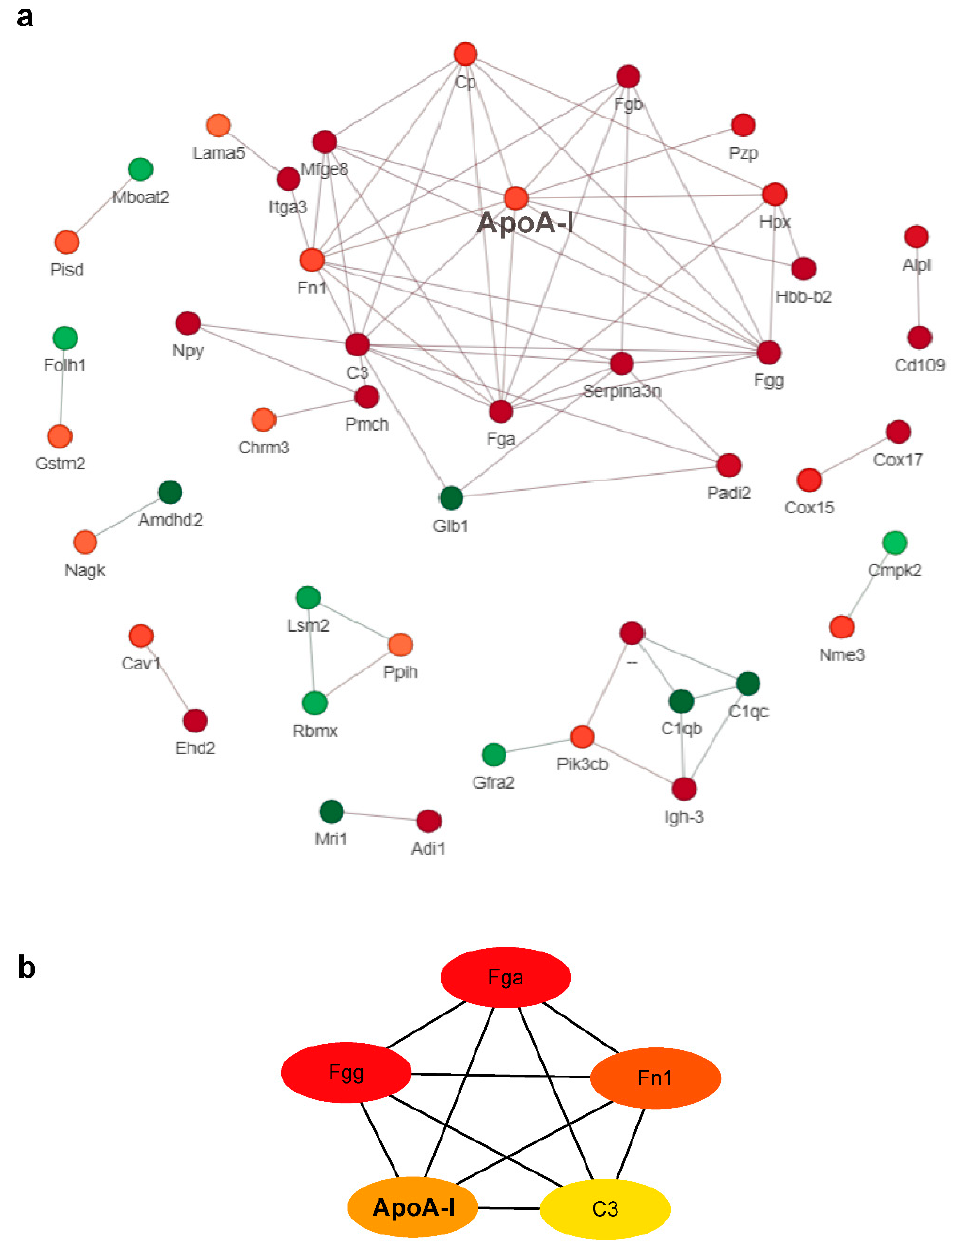
Figure 4. Protein–protein interaction network and screening of hub proteins. ( a ) Protein–protein interaction network of the top 50 differential proteins. ( b ) Protein–protein interaction network of the five screened hub proteins. The redder the color, the more protein connections there are in the network.